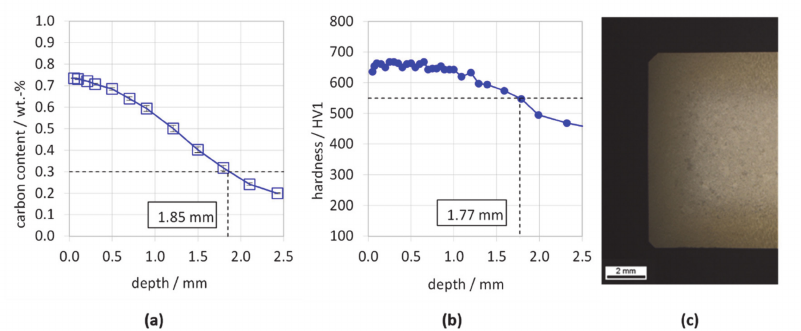
Figure 6. Carbon profile ( a ), microhardness profile ( b ), and micrograph of cross section ( c ) of a sample with target case hardening depth of 2 mm.